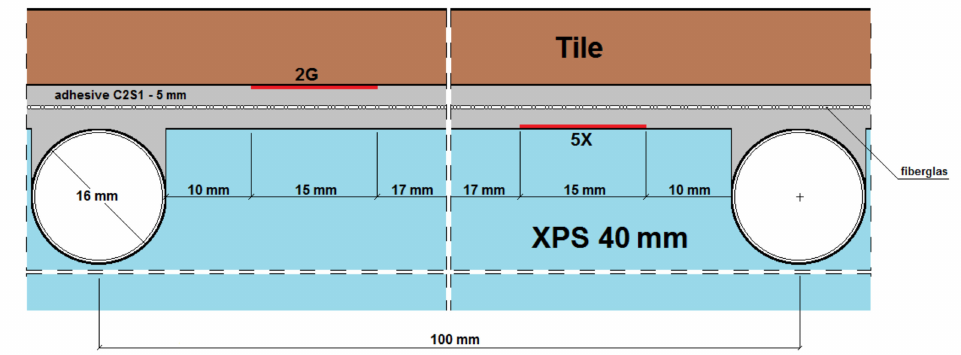
Figure 7. Vertical section I–I of the research model with C2S1 adhesive, without